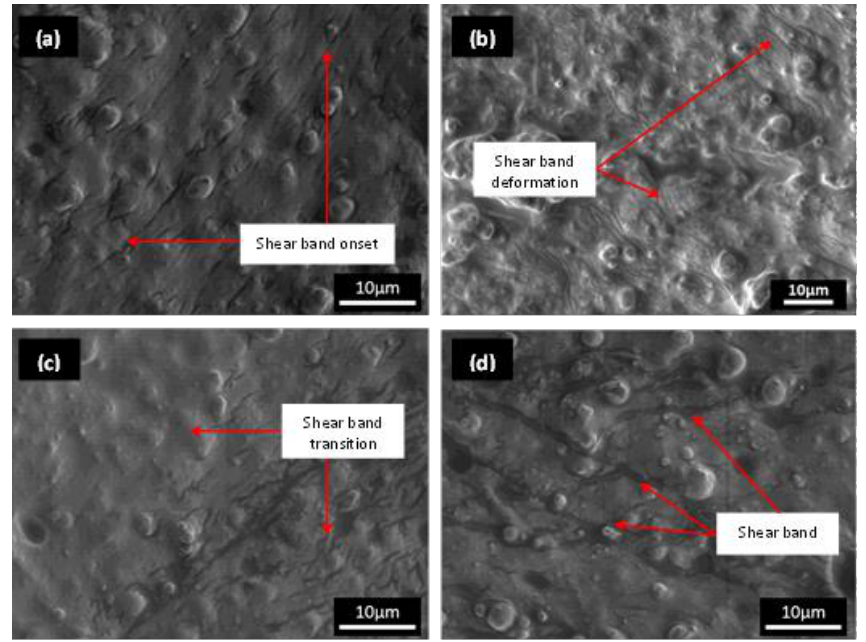
Figure 3. FESEM images of shear band deformation: ( a ) at the sample’s edge during the early test duration, ( b ) at the sample’s edge, ( c ) at the transition toward the center of the test sample, and ( d ) at the sample’s edge at the end of the test.